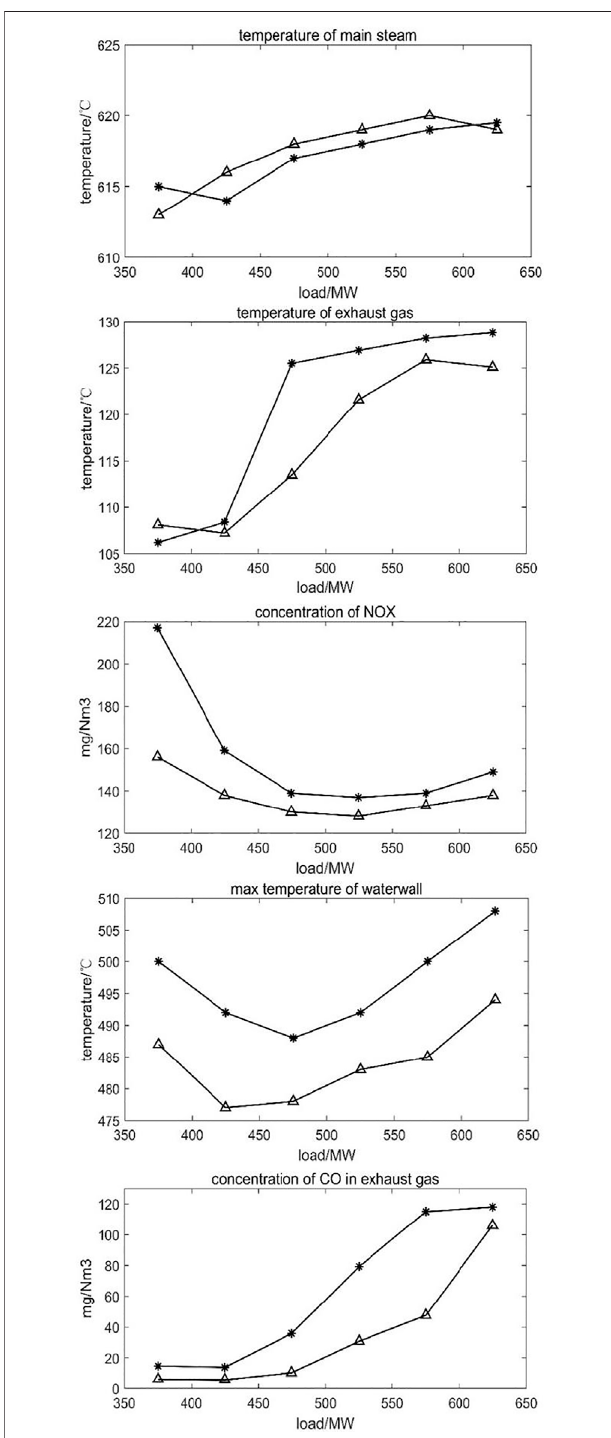
FIGURE 4 | Change in optimized variables from 350 to 650 MW ( “ * ” represents effects before applying the method; “ Δ ” represents effects after applying the method.).